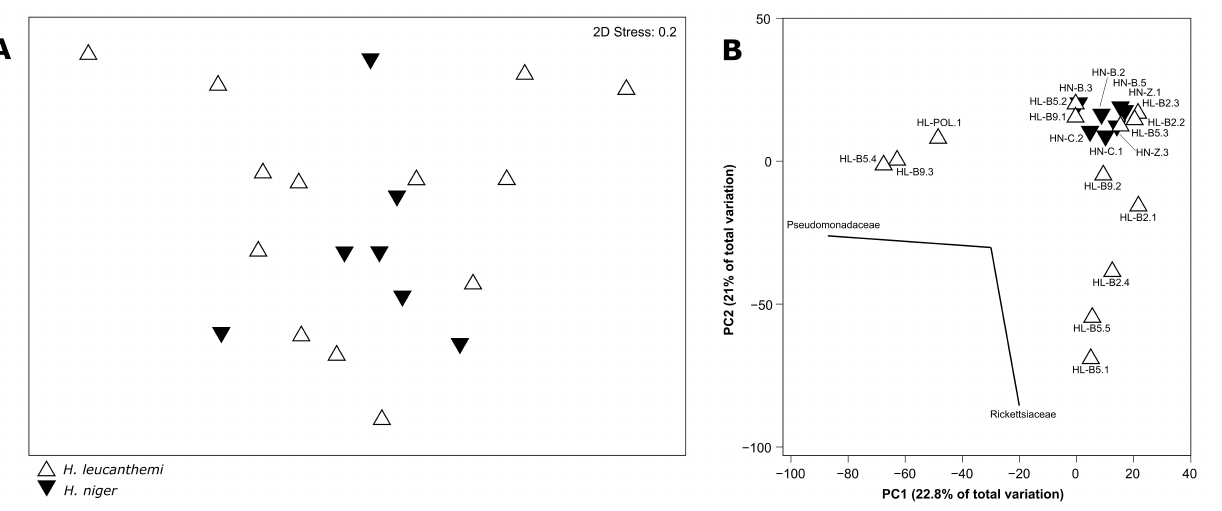
Figure 4. Similarity at the family level among tested microbiota profiles grouped according to the host taxonomy. ( A )—non-metric multidimensional scaling (nMDS) ordination of Haplothrips leucanthemi and H. niger microbial communities; ( B )—principal-coordinate analysis (PCoA) showing a two-dimensional ordination of tested microbiota profiles.